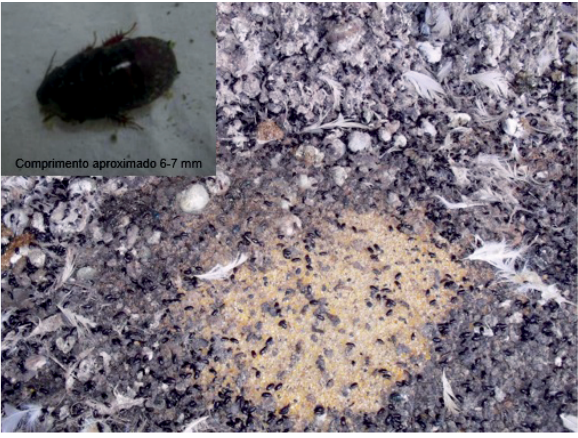
Figure 2. Poultry houses with manure removal through mechanical treadmills.